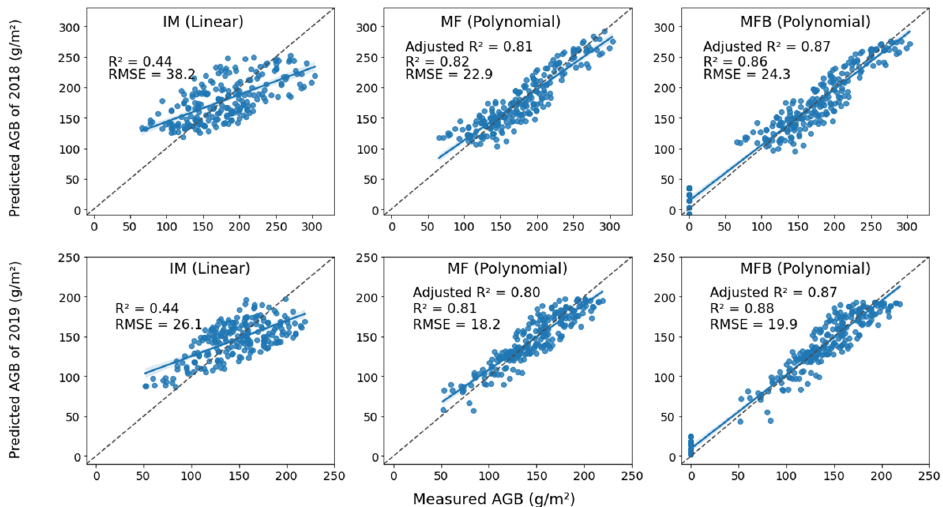
Figure 8. Cross validation scatterplots of predicted versus in situ measured AGB (IM is the initial model, MF is the mowing ratio modified model, MFB is the model modified by both mowing ratio and bare ground metrics).